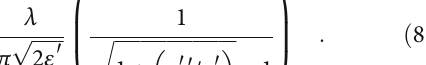
is the microwave incident power, P in